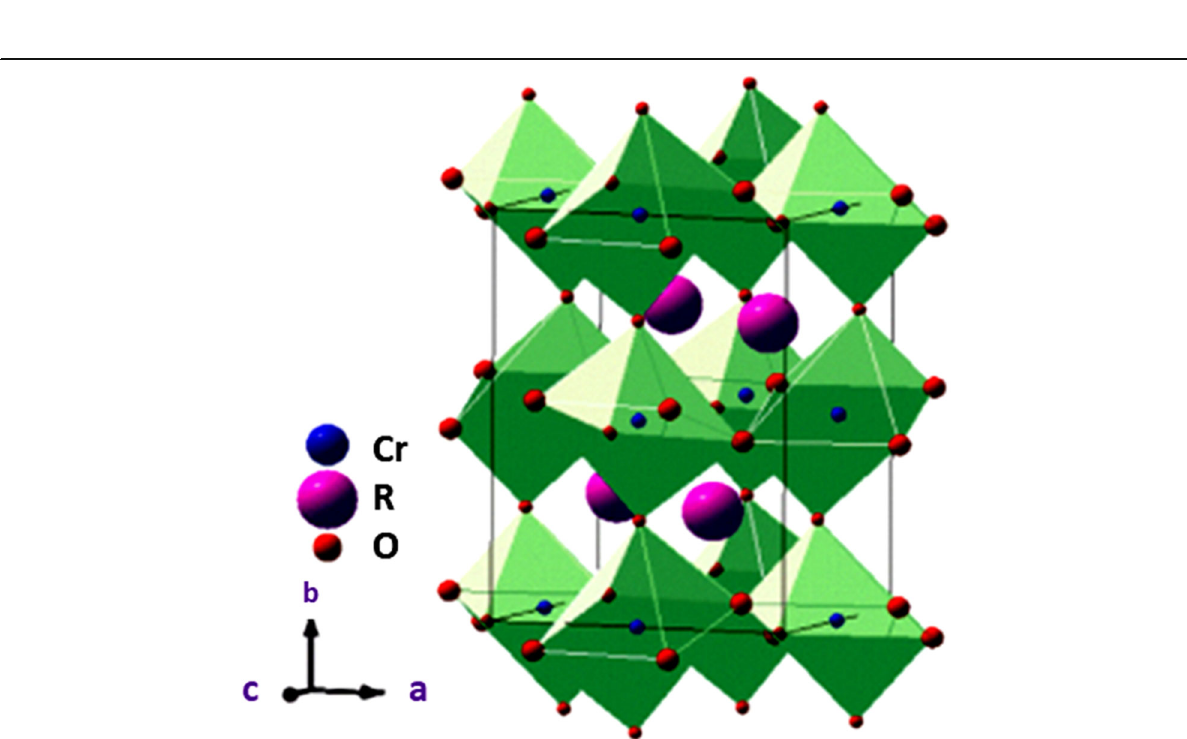
Fig. 8 Distorted orthorhombic perovskite crystal structure of RCrO 3 . Adapted from Fender et al.